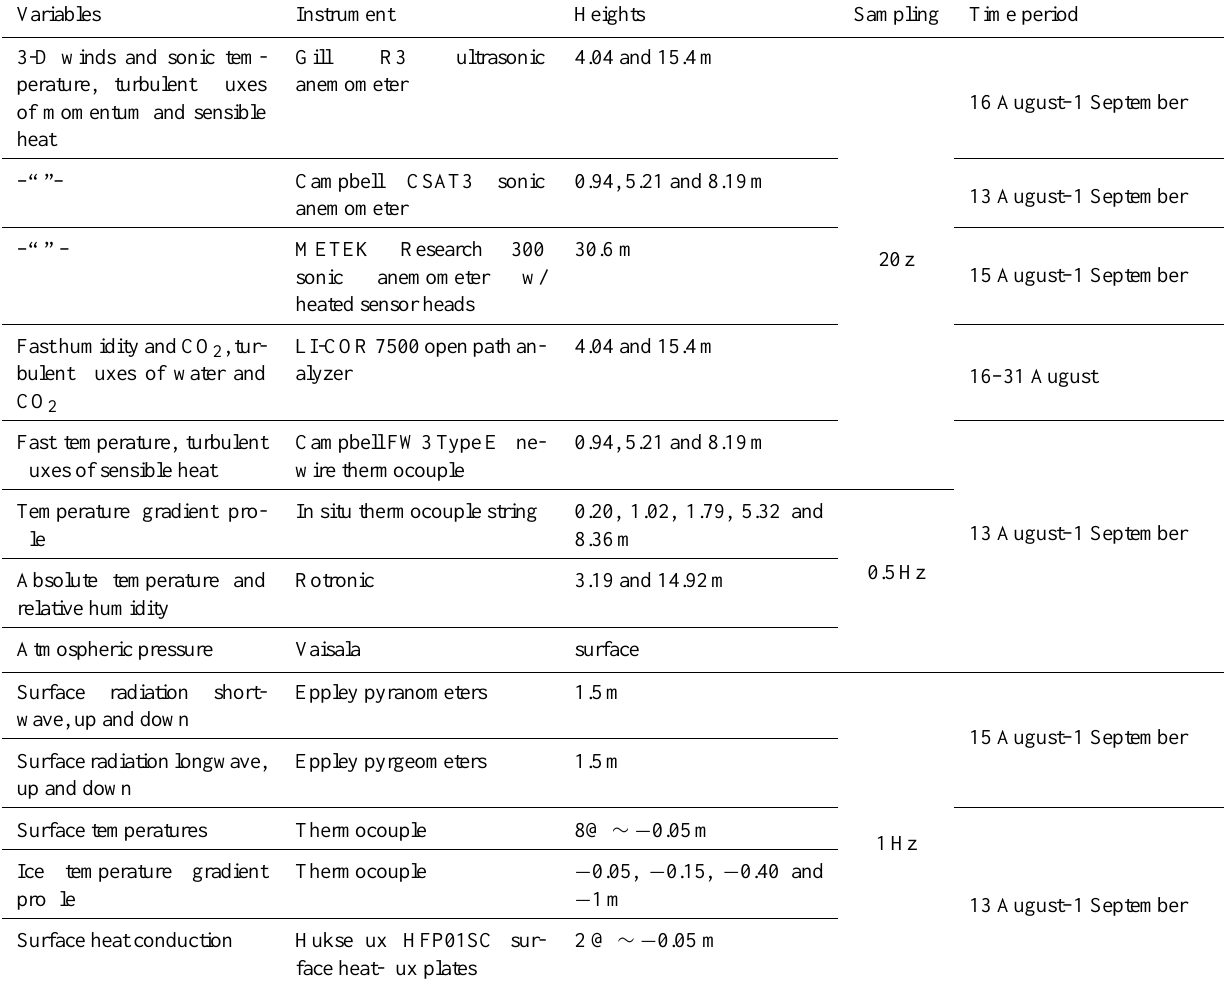
Table A2. List of micrometeorological instrumentation at the “Met Alley” site.